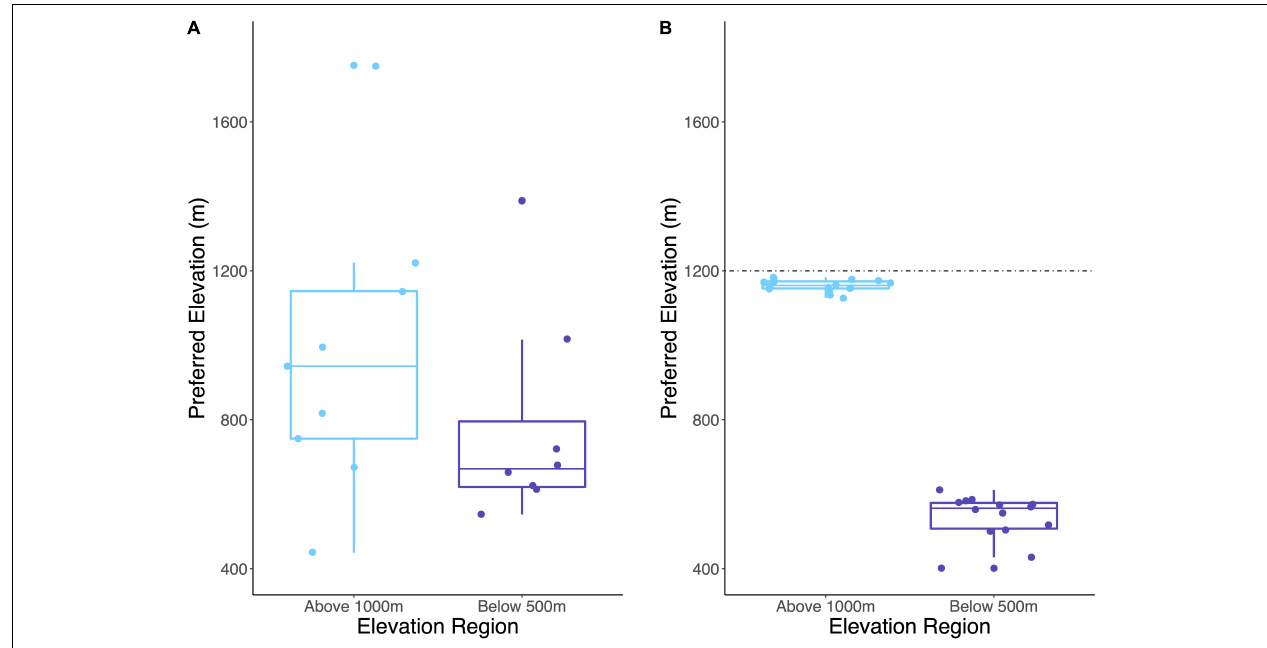
FIGURE 6 | Abundance-weighted average elevation of each indicator OTU or its conspecific representative is represented as preferred elevation for (A) continental-scale distribution of Streptomyces and (B) the distribution of Streptomyces at WM. The dashed line indicates maximum elevation sampled at WM. Preferred elevations are significantly different between High and Low indicator OTUs at WM (Welch’s t-test, p <